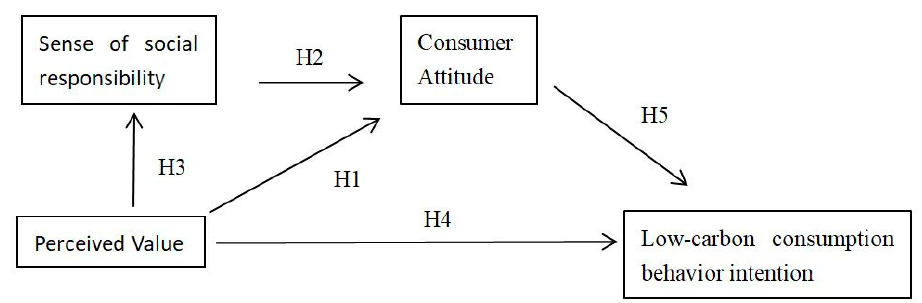
Figure 1. Model diagram of tourists’ low-carbon consumption behavior intention.